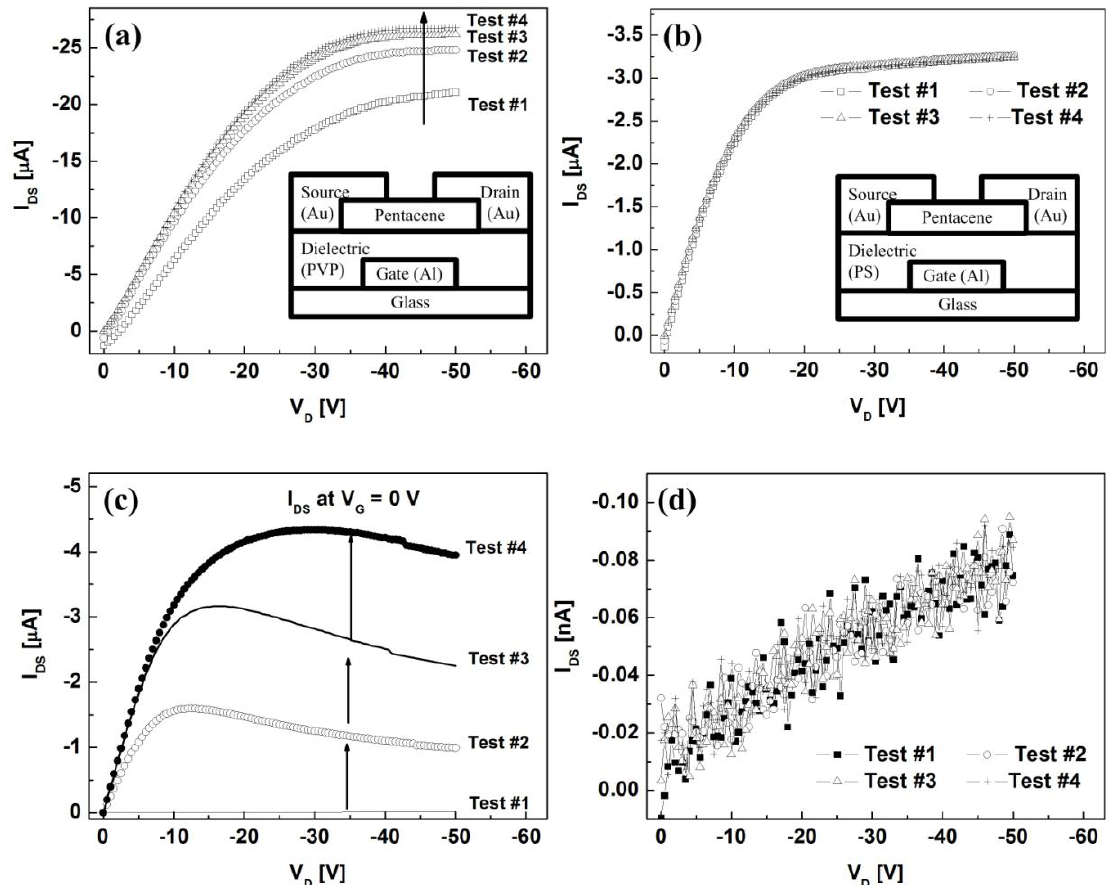
Figure 3. Output characteristics of the OTFTs with (a) the PVP layer and (b) the PS layer at V =  30 V in sequence. The insets show the schematic representations of the fabricated G OTFTs. Output characteristics of the OTFTs with (c) the PVP layer and (d) the PS layer at V = 0 V during repetitive G